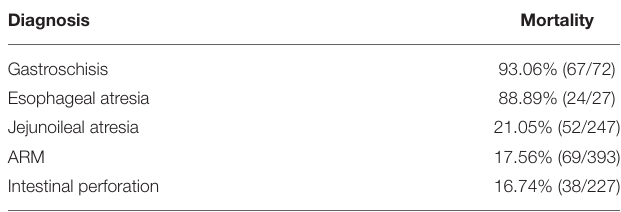
TABLE 3 | Diagnoses with the highest